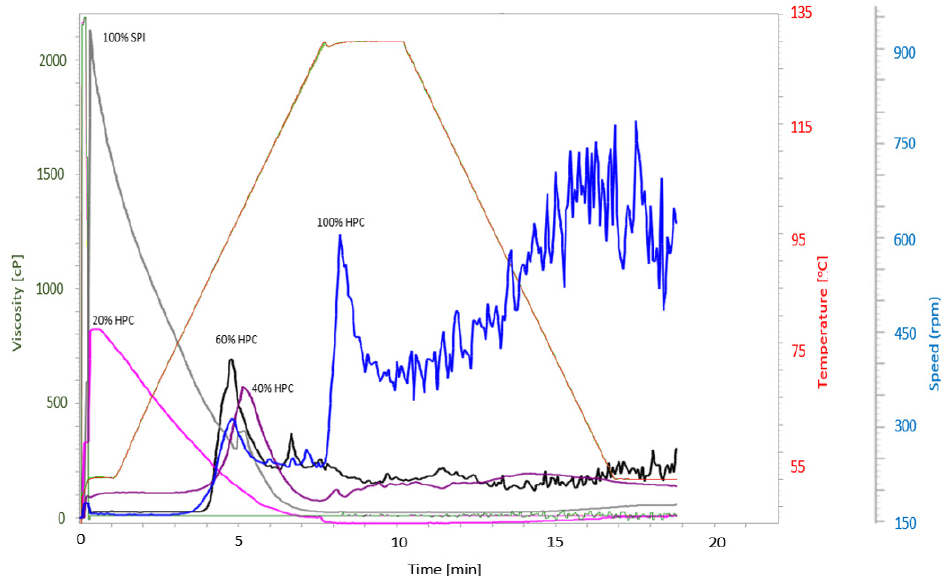
Figure 4. RVA curves for the raw materials and mixtures. (100% SPI: grey, 100% HPC: blue, 20% HPC: pink, 40% HPC: purple, 60% HPC: black.).